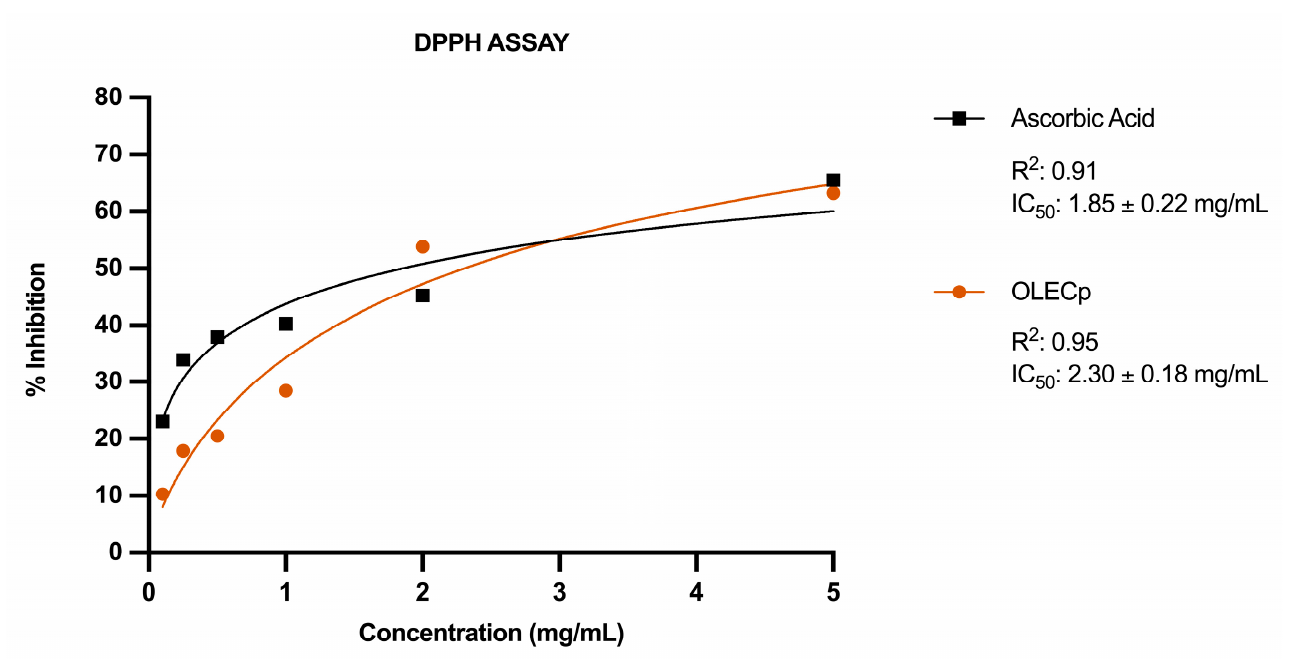
Figure 5. DPPH Assay. Antiradical activity (% Inhibition) and IC 50 of OLECp and Ascorbic Acid (positive control). Data were fitted using nonlinear regression to compute the IC 50 values. The results are expressed as mean ± SEM ( n = 3).